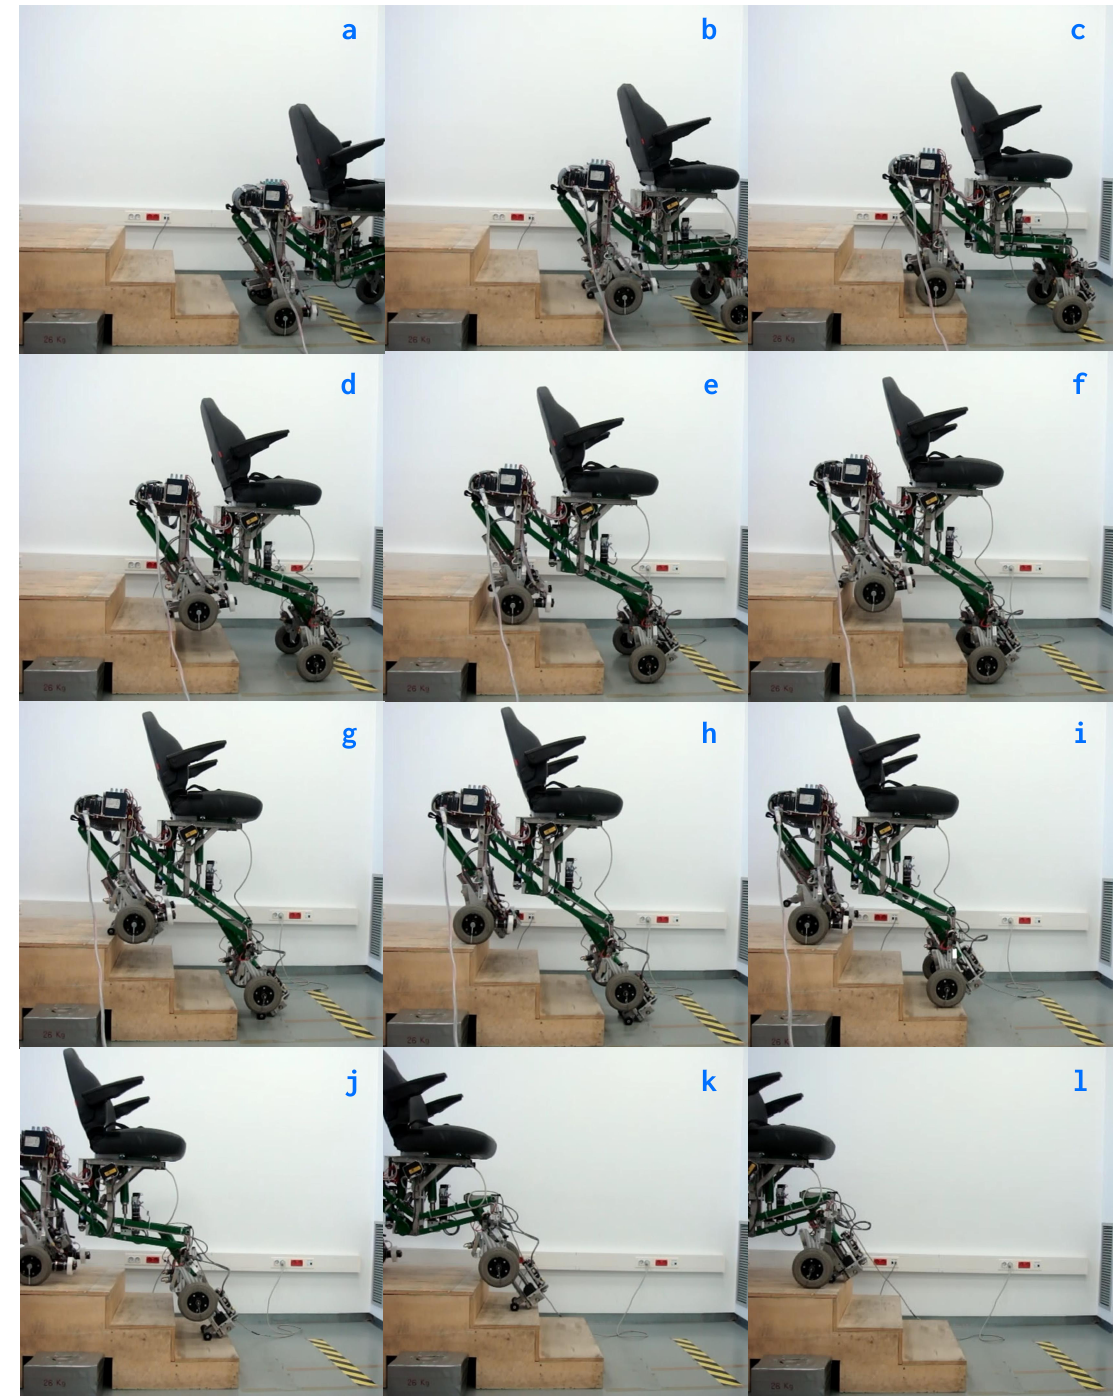
Figure 19. Sequence of climbing process when it surpasses a three-step staircase. All possible configurations of the SCMS are included; Configuration 1 in ( a , c , e , i , l ); Configuration 2 in ( b , d , f ); Configuration 3 in ( h , j , k ); and Configuration 4 in ( g ). See the video referenced in the Supplementary